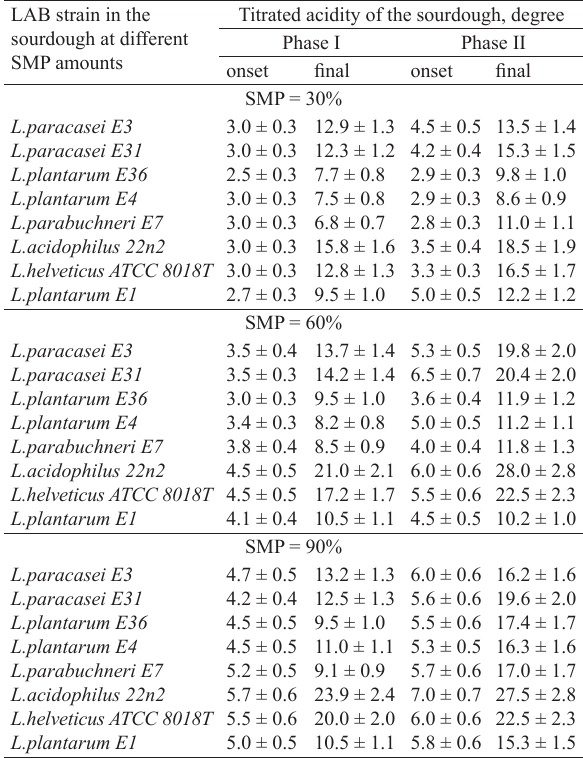
Table 5 Effect of various LAB strains on the sourdough